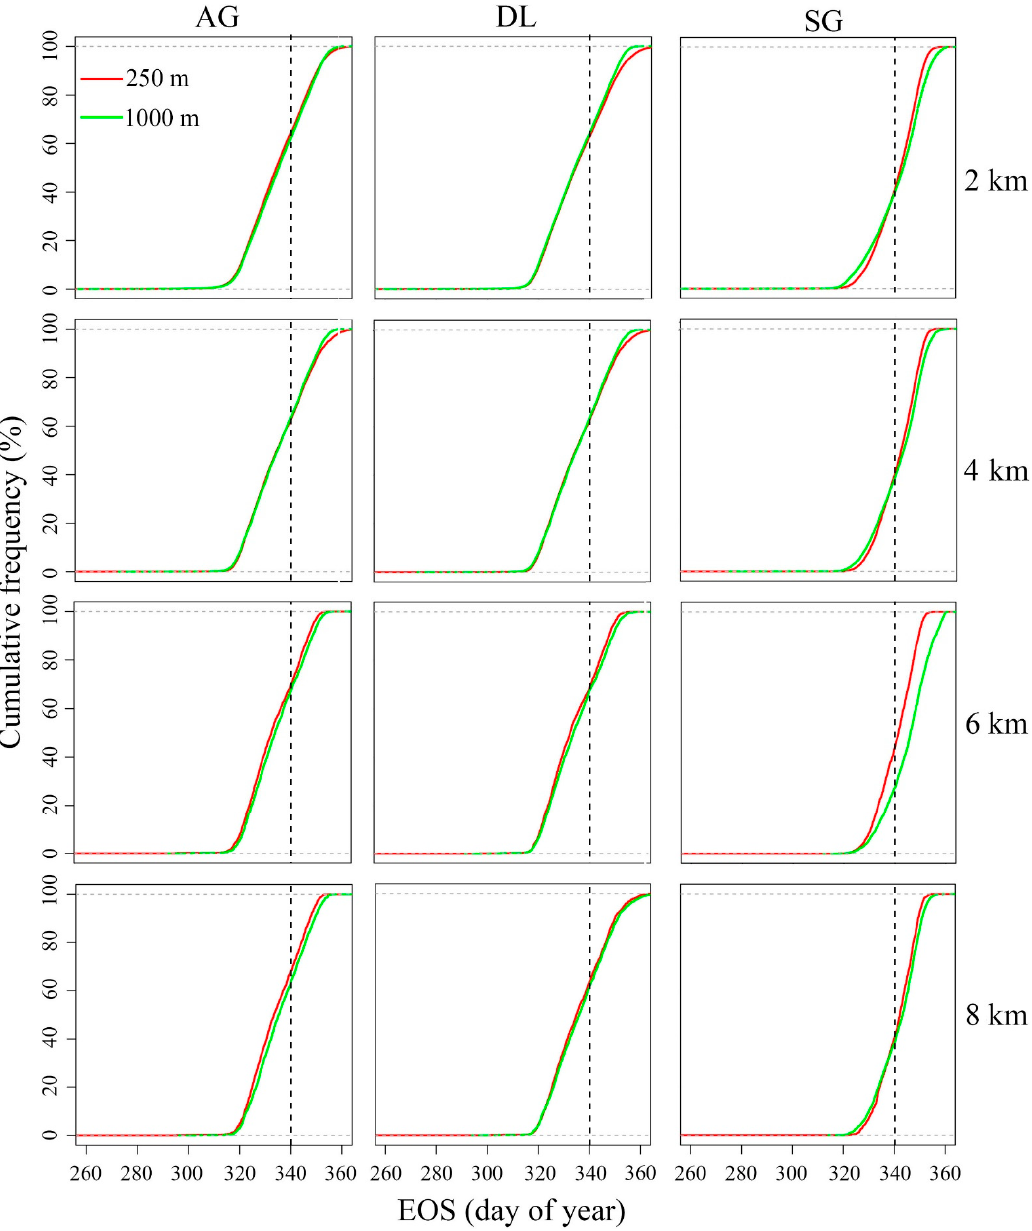
Figure 13. The cumulative distribution functions (CDFs) of the up-scaled EOSs from 250 m and 1000 m EOSs. (SG, Savitzky-Golay; AG, asymmetric Gaussian; DL, double logistic). Similar to the SOS results, we calculated the absolute difference of the 250 m and 1000 m EOS retrieved by AG-filtering (Figure 14). When the spatial scale was 2 km, the absolute difference was within 5 d in 80% of the study area. The absolute differences were largest in the northern ridge area, and smallest in the southern and western regions. As the scale increased, the spatial difference decreased gradually, and when the scale was 8 km, 80% of the study area showed an absolute difference of less than three